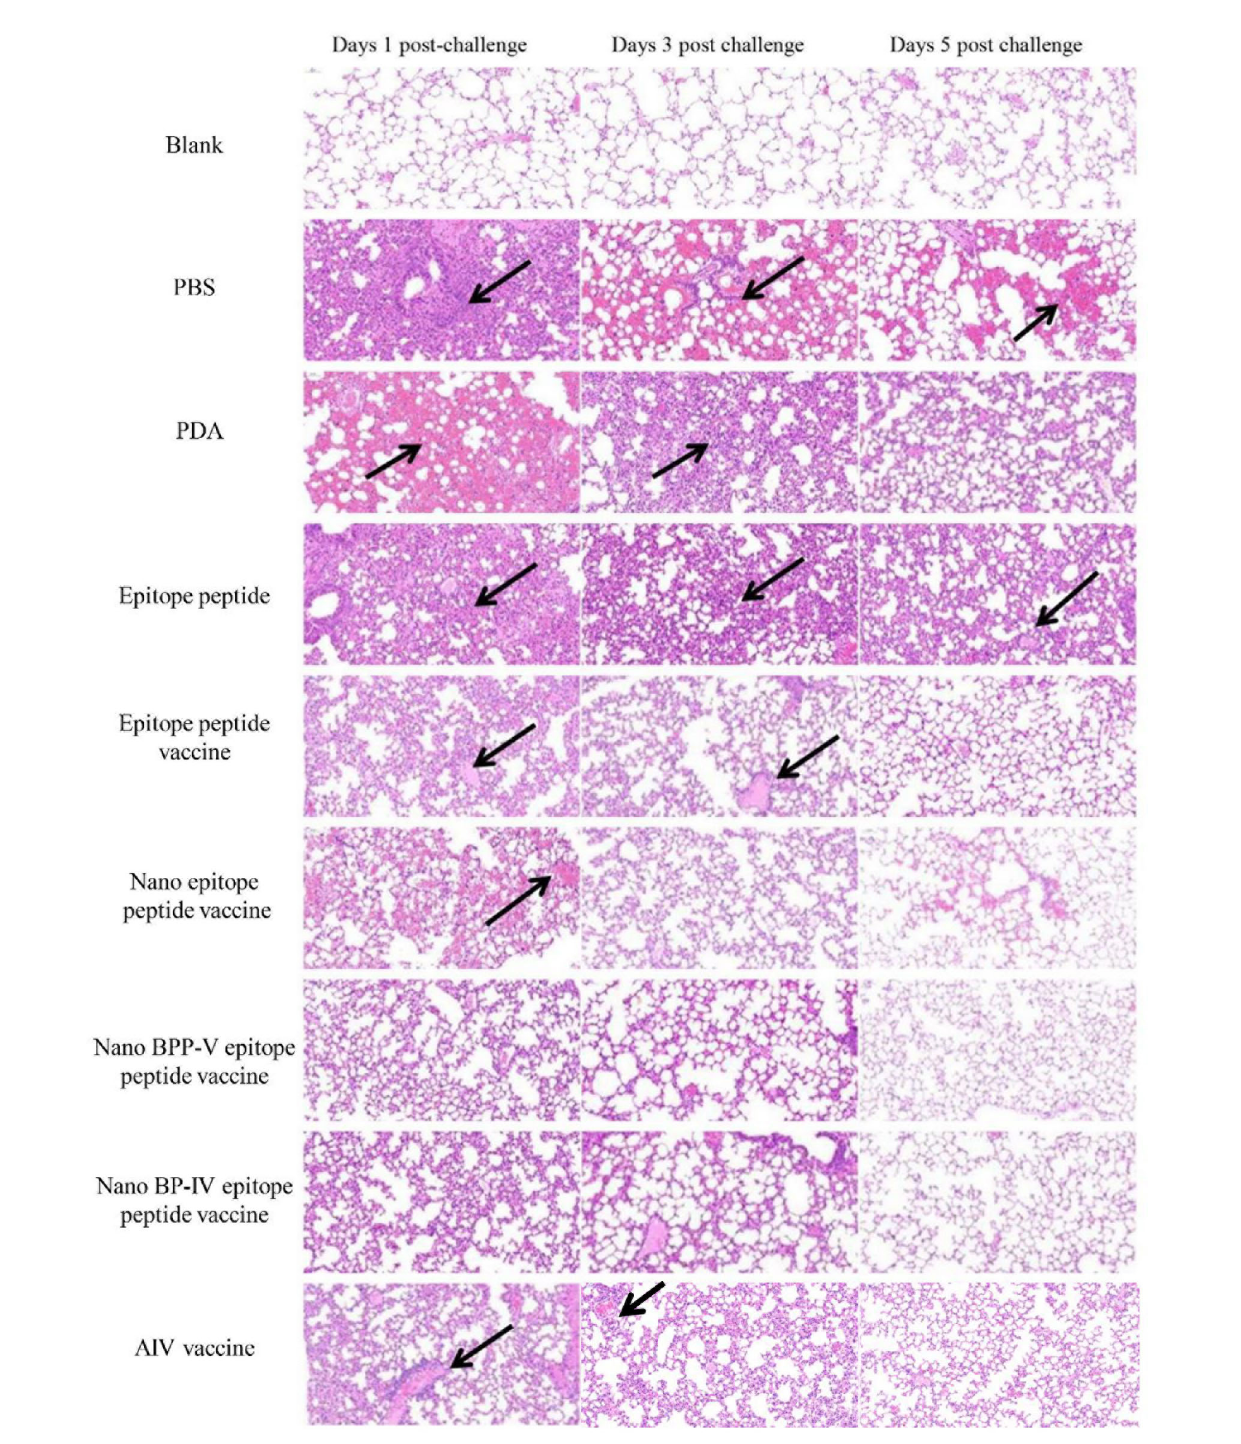
FIGURE 9 | Representative histopathological images of processed lung sections on days 1, 3 and 5 after the challenge. Mice were challenged on day 21 after immunization, and their lungs were collected on days 1, 3 and 5 after the challenge. Lung sections were stained with H&E (n = 5). The arrows indicate lesion characteristics, including congestion, lymphocytic in fi ltration, microvascular embolism and hemorrhage.